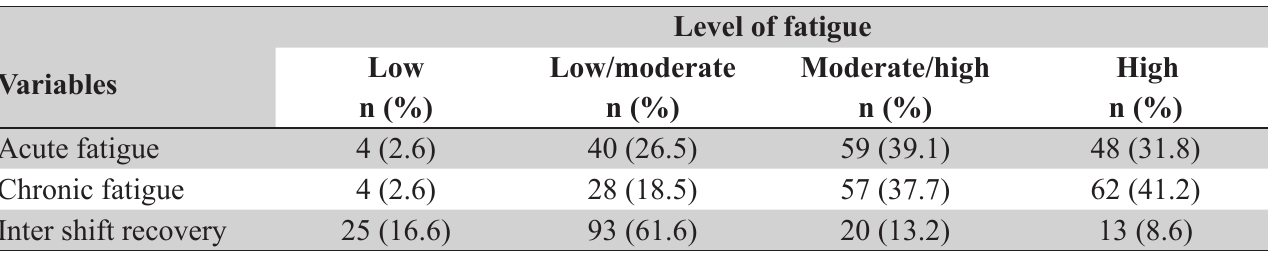
Table 1: Participants’ level of acute fatigue, chronic fatigue and inter shift recovery (n=151).